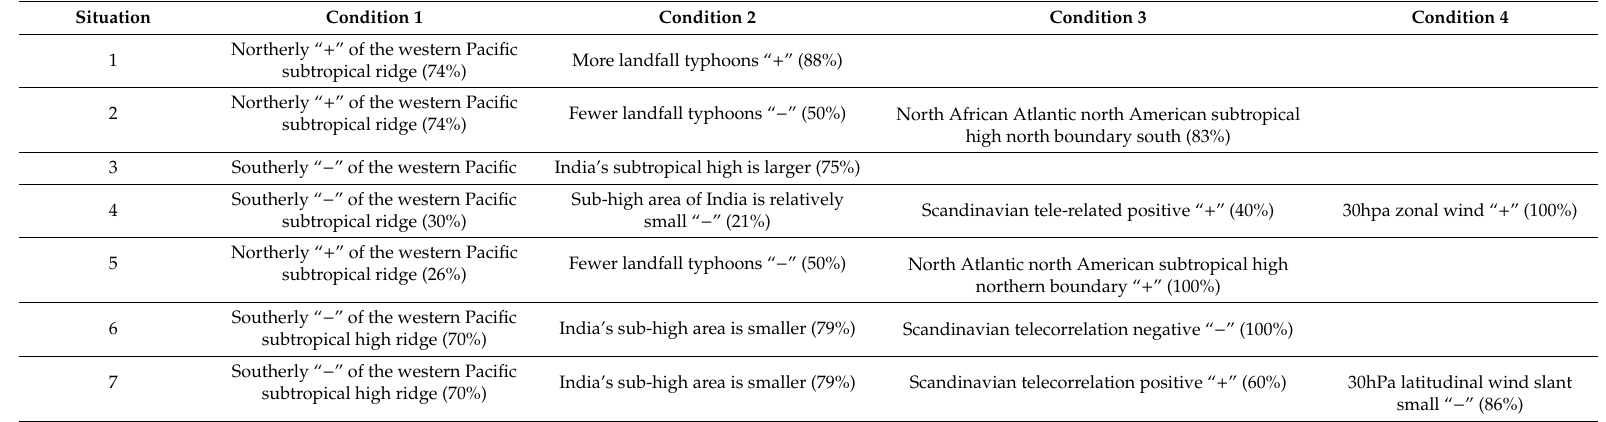
Table 1. Combination of summer precipitation trend and circulation index model based on the CART algorithm in Chongqing.